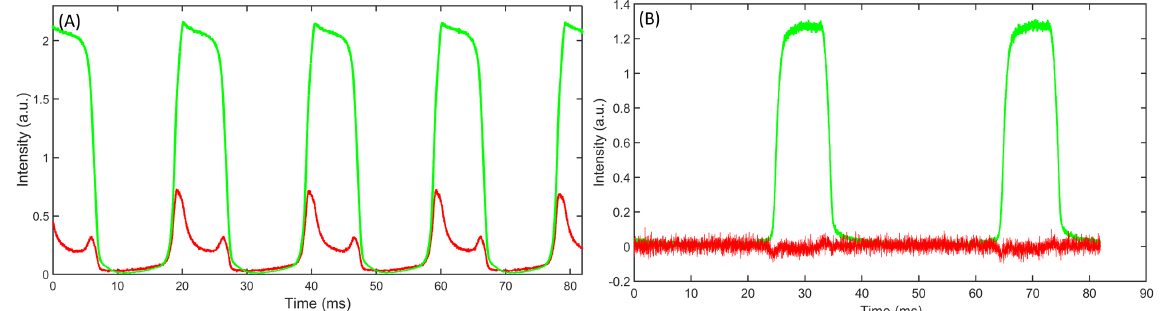
Figure 3. Effect of surfactant on the presence of anti-Stokes emission from RhB droplets flowing in a microfluidic channel. ( A ) Anti-Stokes and Stokes emission of rhodamine-B is present when droplets are in 2% Krytox surfactant; ( B ) Anti-Stokes emission (red) is practically not detected in the case of large droplets when using a non-electrically charged surfactant (KryJeffa) in HFE